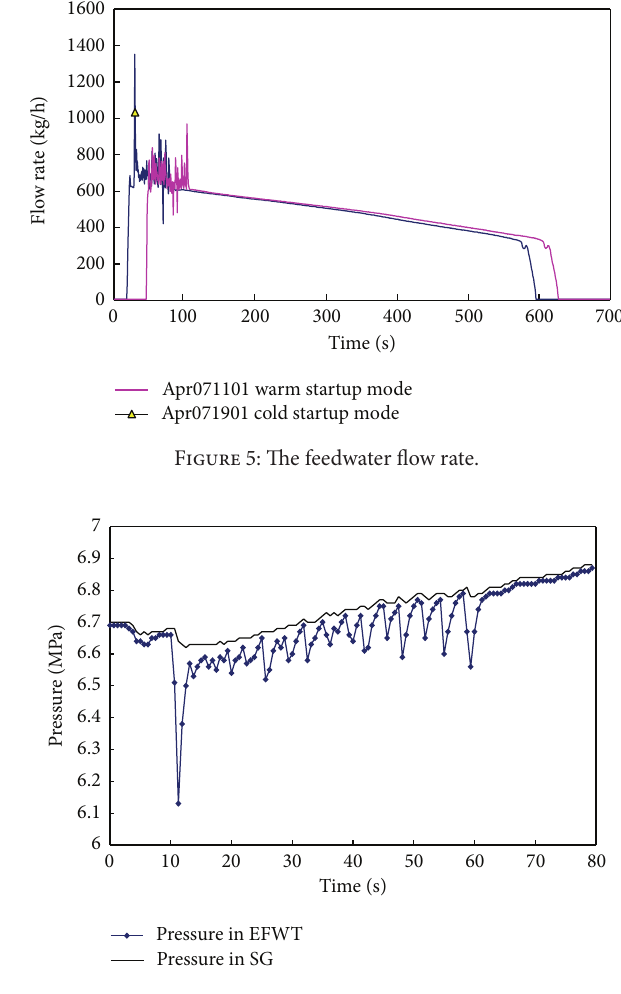
Figure 6: The pressure fluctuation when water hammer